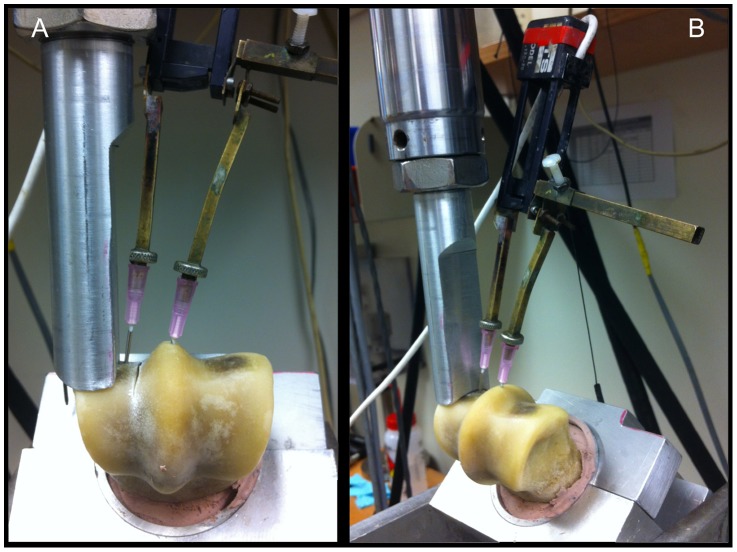
Photograph illustrating the custom-made jig that secures the distal end of the MC3 bone to the platen of a materials testing machine (MTS 858, Minneapolis, MN).(A) Drill holes 1.25 mm in diameter were made on the lateral and medial side of the artificial slot or crack array in the parasagittal condylar groove. (B) Hypodermic needles (18 g) were then placed in the drill holes and attached to an extensometer to measure motion across the slot or crack. The actuator consisted of a metal rod that was contoured to conform to the curved surface of the condyle.